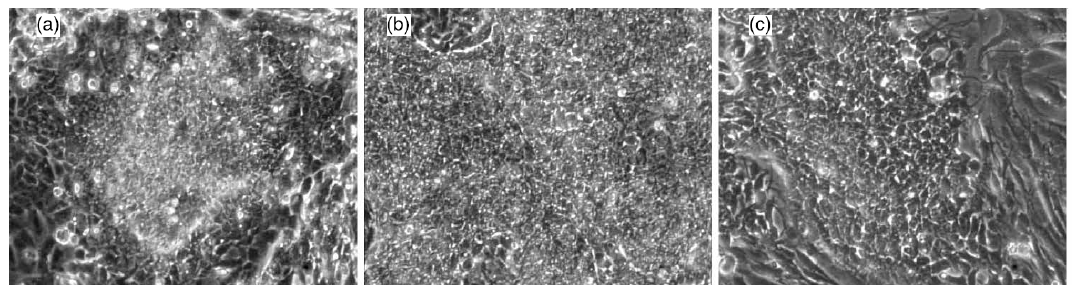
Figure 5. Representative images of chimpanzee iPS clones generated by (a) retrovirus, (b) Sendai virus and (c) episomal EBNA vector. Images were taken ∼ 25–30 days after the final infection or transfection. After colonies have been isolated onto mitomycin-treated mouse embryo fibroblasts, they expand rapidly and acquire typical pluripotent cell